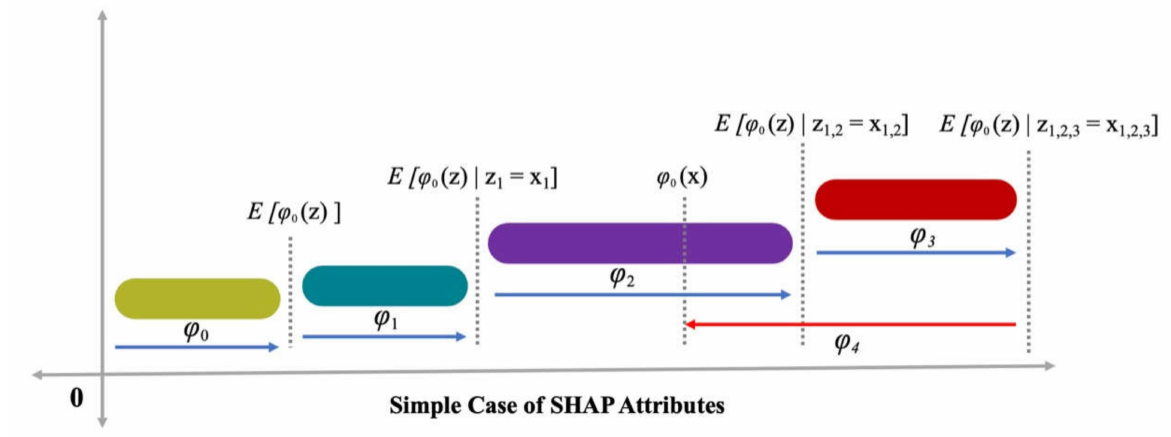
Figure 4. SHAP attributes